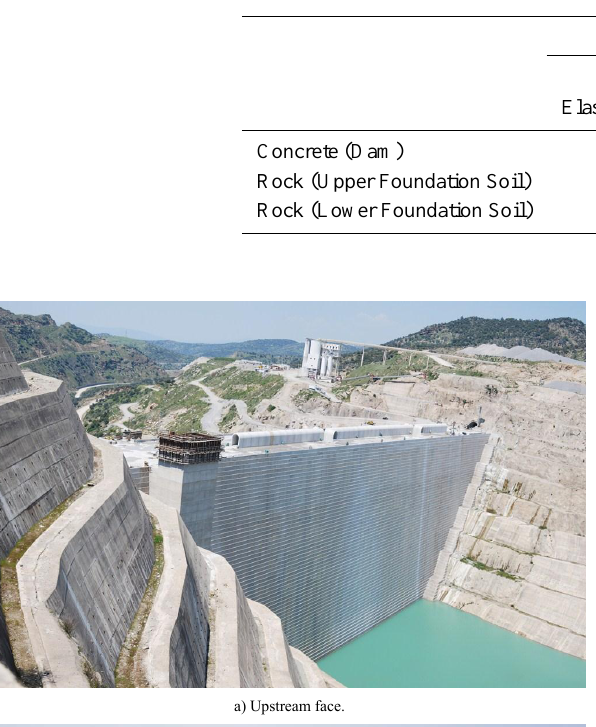
Table 1. The material properties of C¸ine RCC dam (DSI, 2012).